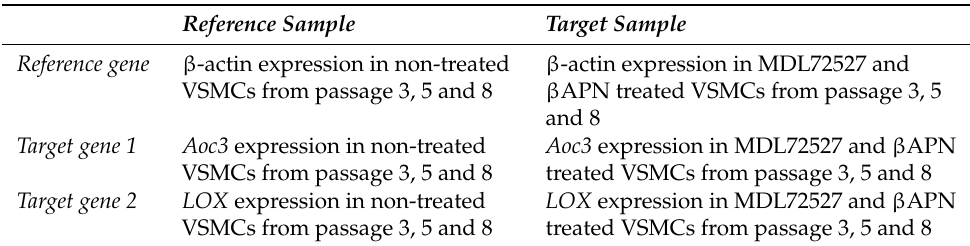
Table 2. An illustration of the qPCR experimental